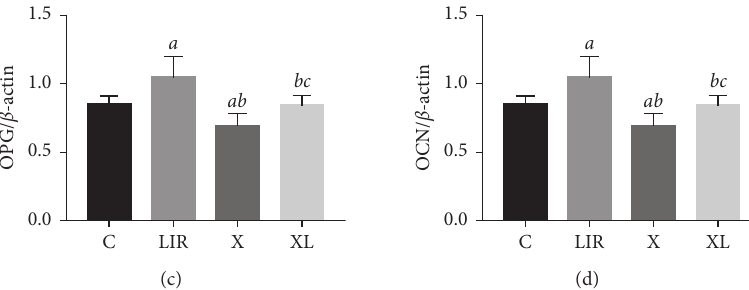
Figure 9: XMD8-92 downregulated the Col-1, OPG, and OCN protein expression. The protein expression of Col-1, OPG, and OCN was detected by western blot after the MC3T3-E1 cells were pretreated with 10 μ M XMD8-92 for 1h followed by 100nM liraglutide treatment for 48h (a). Quantitative analysis of the protein level of Col-1 (b), OPG (c), and OCN (d) in MC3T3-E1 cells after being pretreated with 10 μ M XMD8-92 for 1h followed by 100nM liraglutide treatment for 48h. aP < 0.05 compared with control, bP < 0.05 compared with 100nM liraglutide, and cP < 0.05 compared with XMD8-92 group. C: control group, LIR: 100nM liraglutide; X: XMD8-92; X +LIR: XMD8-92 with 100nM liraglutide.